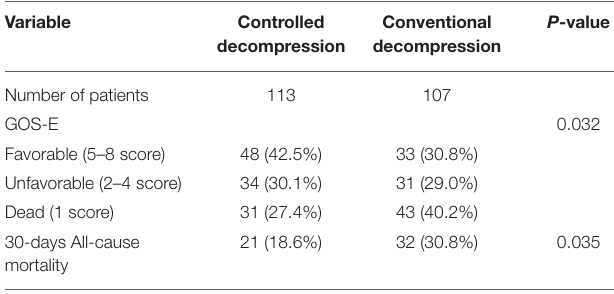
TABLE 2 | Comparison of endpoint-clinical outcomes between the two